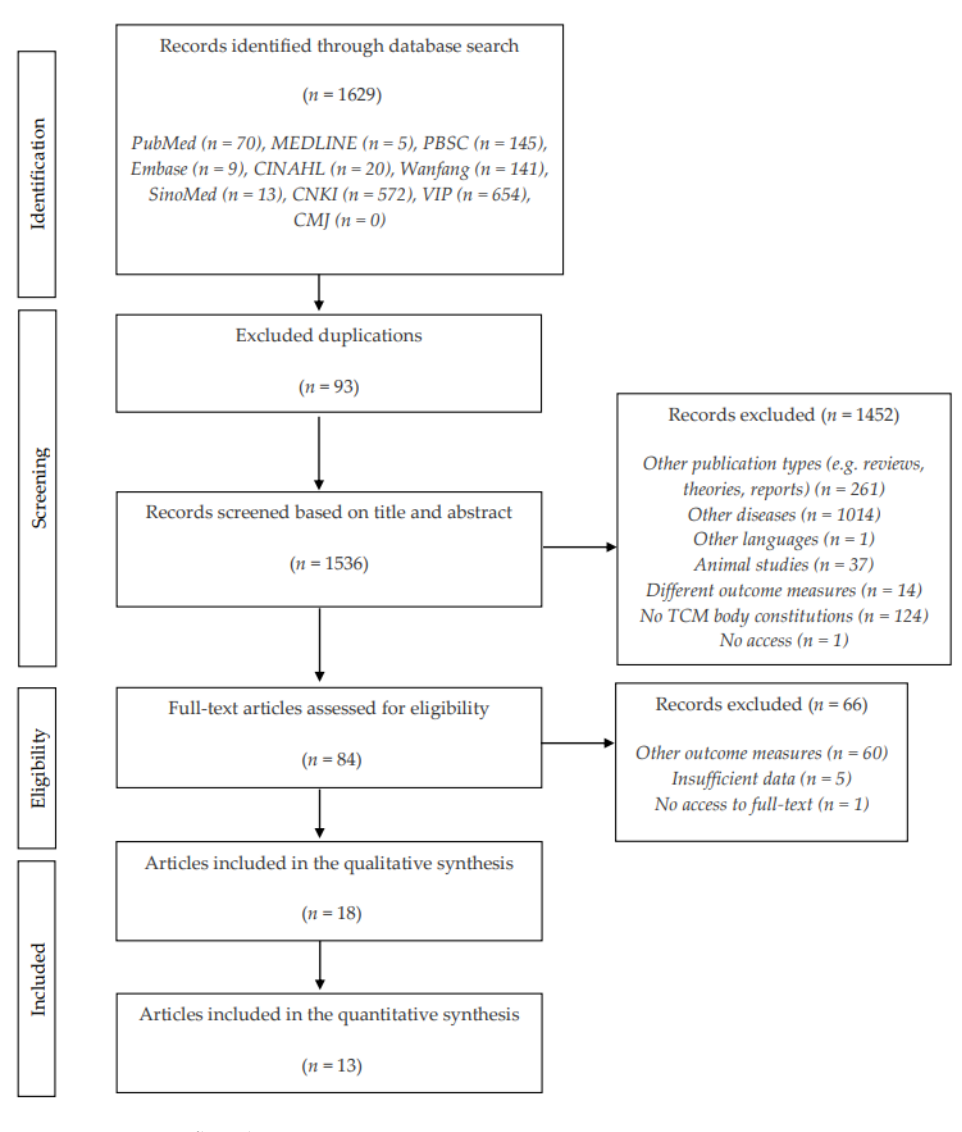
Figure 1. PRISMA flowchart.